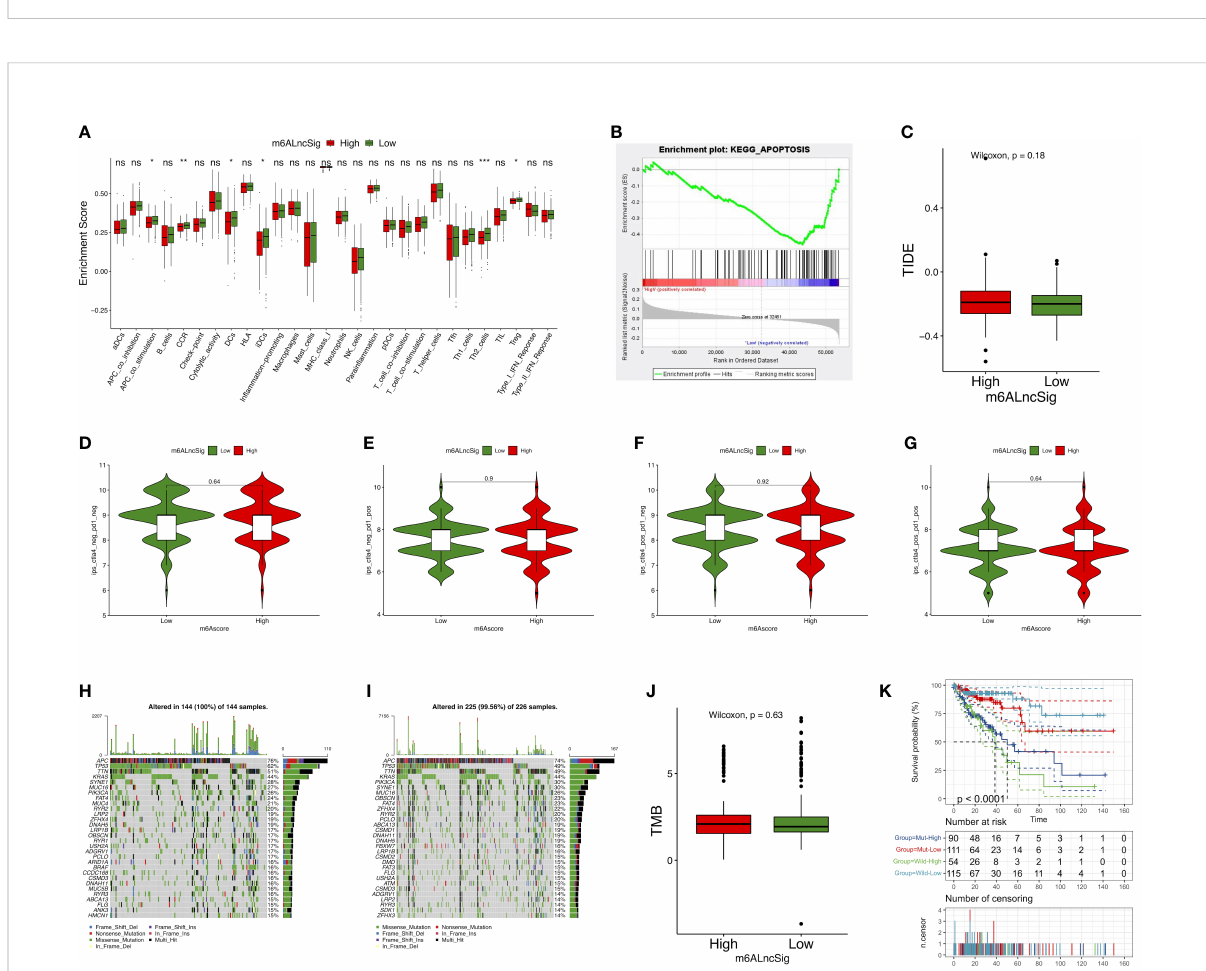
FIGURE 9 Evaluation of tumor immune microenvironment (TIME) and tumor immunotherapy response using m6ALncSig in the TCGA entire set. (A) The box diagram illustrating the different in fi ltration levels of immune cells in the high- and low-risk groups. (B) Gene Sets Enrichment Analysis (GSEA). (C) The predicted difference of TIDE in the high- and low-risk groups. (D – G) The correlation of the risk scores with IPS in four subgroups, CTLA4 − PD1 − (D) , CTLA4 − PD1 + (E) , CTLA4 + PD1 − (F) , and CTLA4 + PD1 + (F) . (H, I) Waterfall plot of the genes with high mutation frequency in the high- (H) and low-risk groups (I) . (J) TMB difference between the high- and low-risk groups. (K) KM curve for patients classi fi ed based on TP53 mutation status and m6ALncSig. ns, Not signi fi cant; *p < 0.05, **p < 0.01, ***p < 0.001.